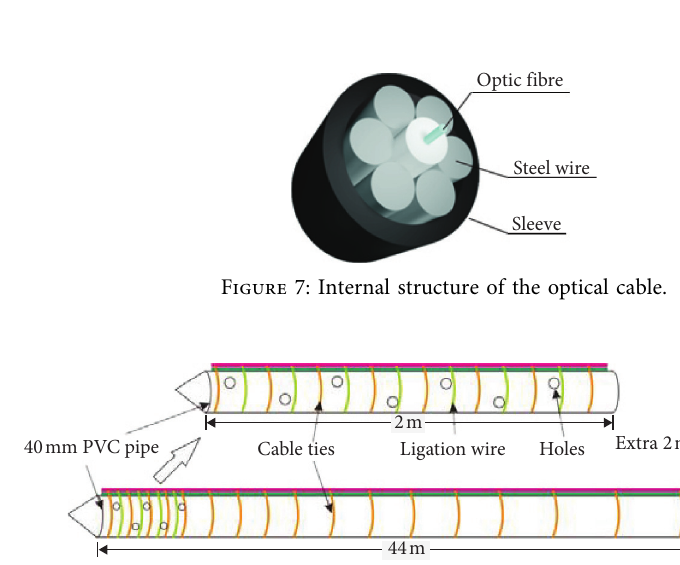
Figure 6: Plan view of optical fibre layout.